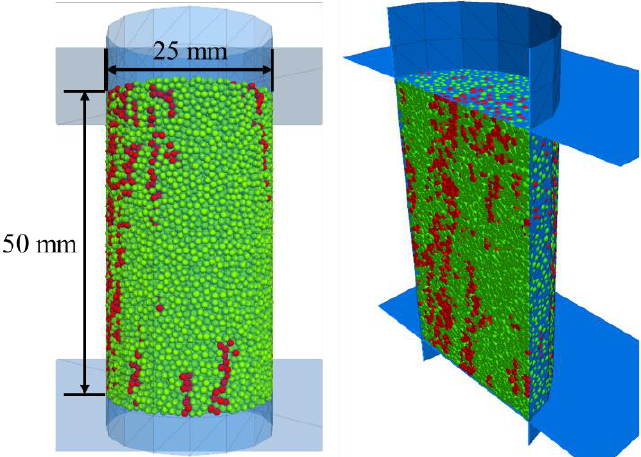
Figure 7. Reconstructed sample with flexible membrane as outer vertical boundary.